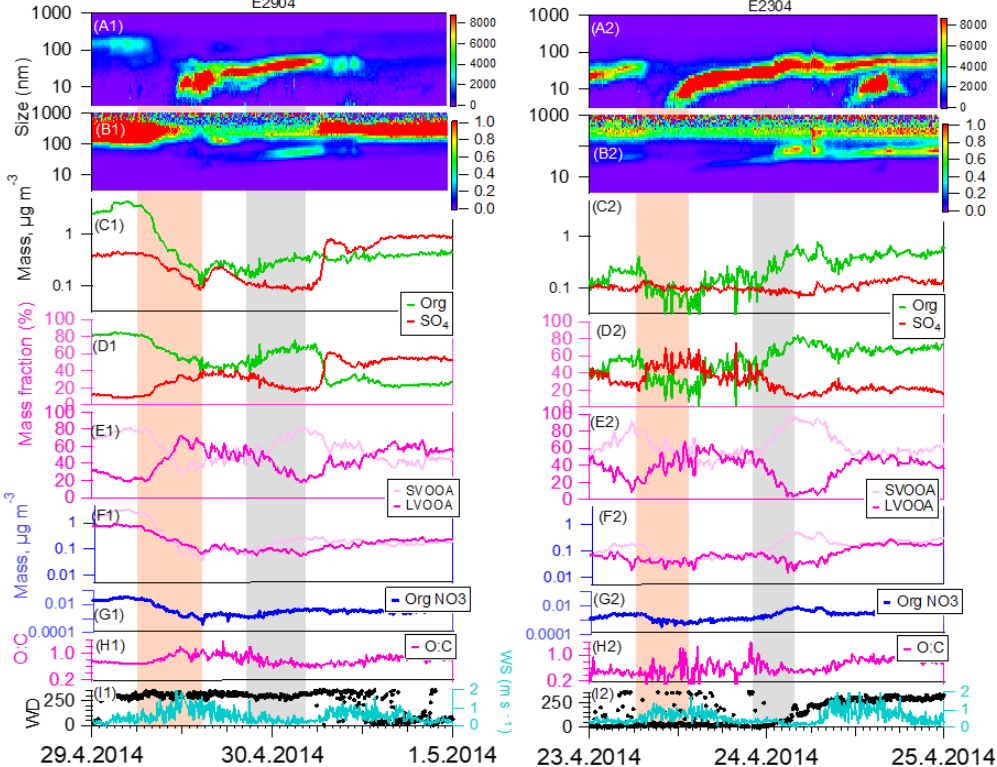
Figure 2. Observation of new particle formation events starting on 29 April 2014 (E2904) and 23 April 2014 (E2304). The orange bars were marked for the analysis before and right after nucleation and the gray bars were for aerosol growth periods. Panels: (a) aerosol number size distributions from DMPS; (b) volume size distributions from DMPS; (c) mass concentrations of organic (green) and sulfate (red) species by AMS; (d) mass fractions of organic and sulfate to total aerosol mass concentrations; (e) mass fractions of LVOOA (pink) and SVOOA (light pink) to total organic aerosol mass concentrations; (f) mass concentrations of LVOOA and SVOOA species determined by PMF; (g) the time series of organic nitrate aerosol; (h) O : C ratio of organic species by AMS; (i) wind speed (WS) and direction